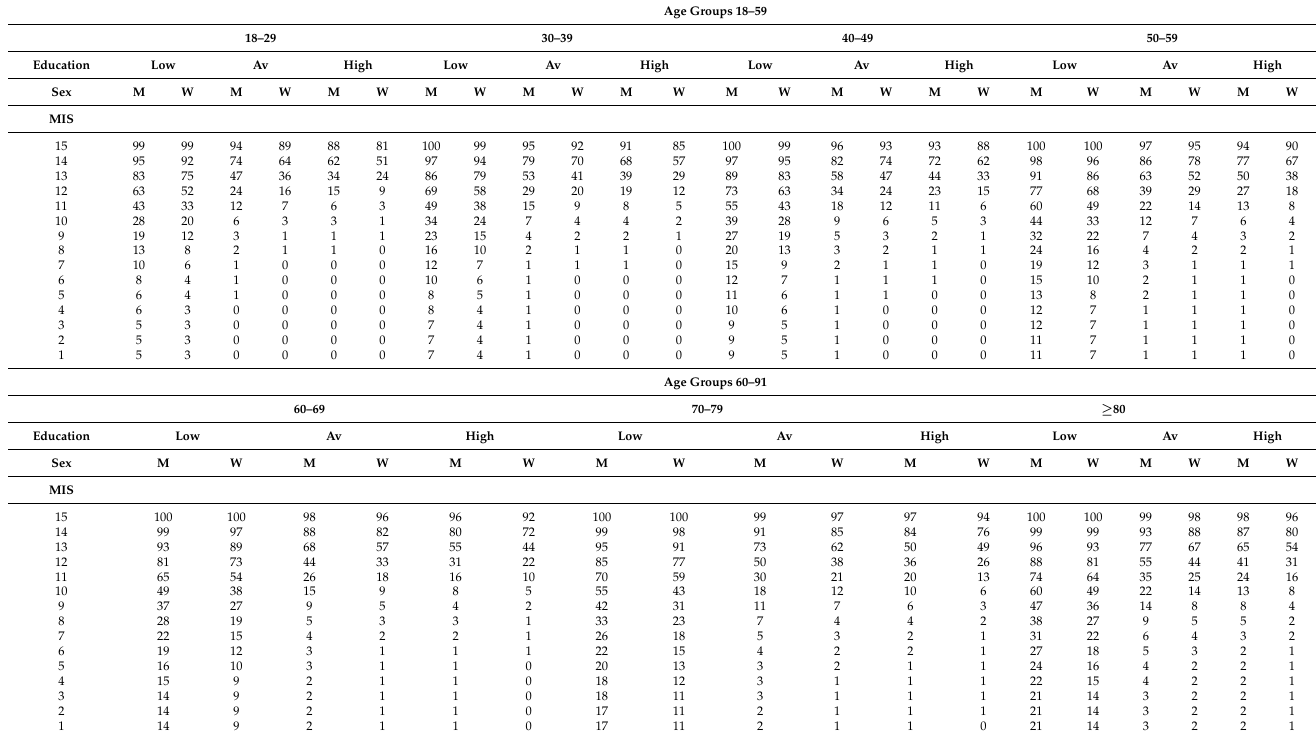
Table A2. Percentile scores for the MoCA Memory Index Score (MIS) per age group, education level, and